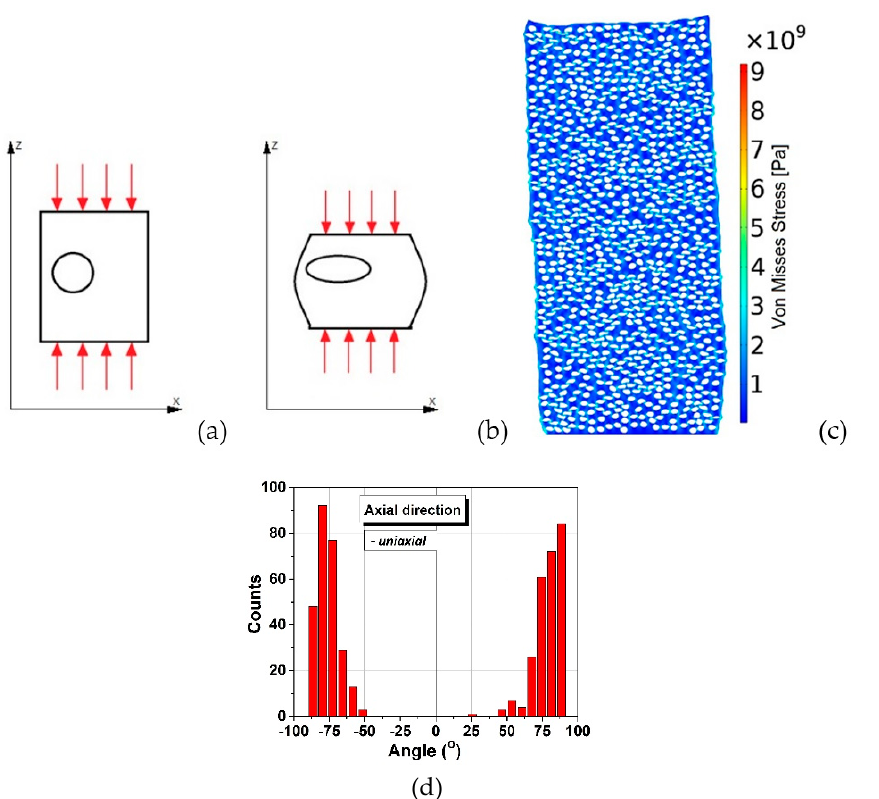
Figure 8. Schematic of uniaxial pressing: ( a ) before pressing, ( b ) after pressing and deformation; ( c ) uniaxially entirely deformed structure; ( d ) angular distribution of inclusions derived for uniaxial pressing.